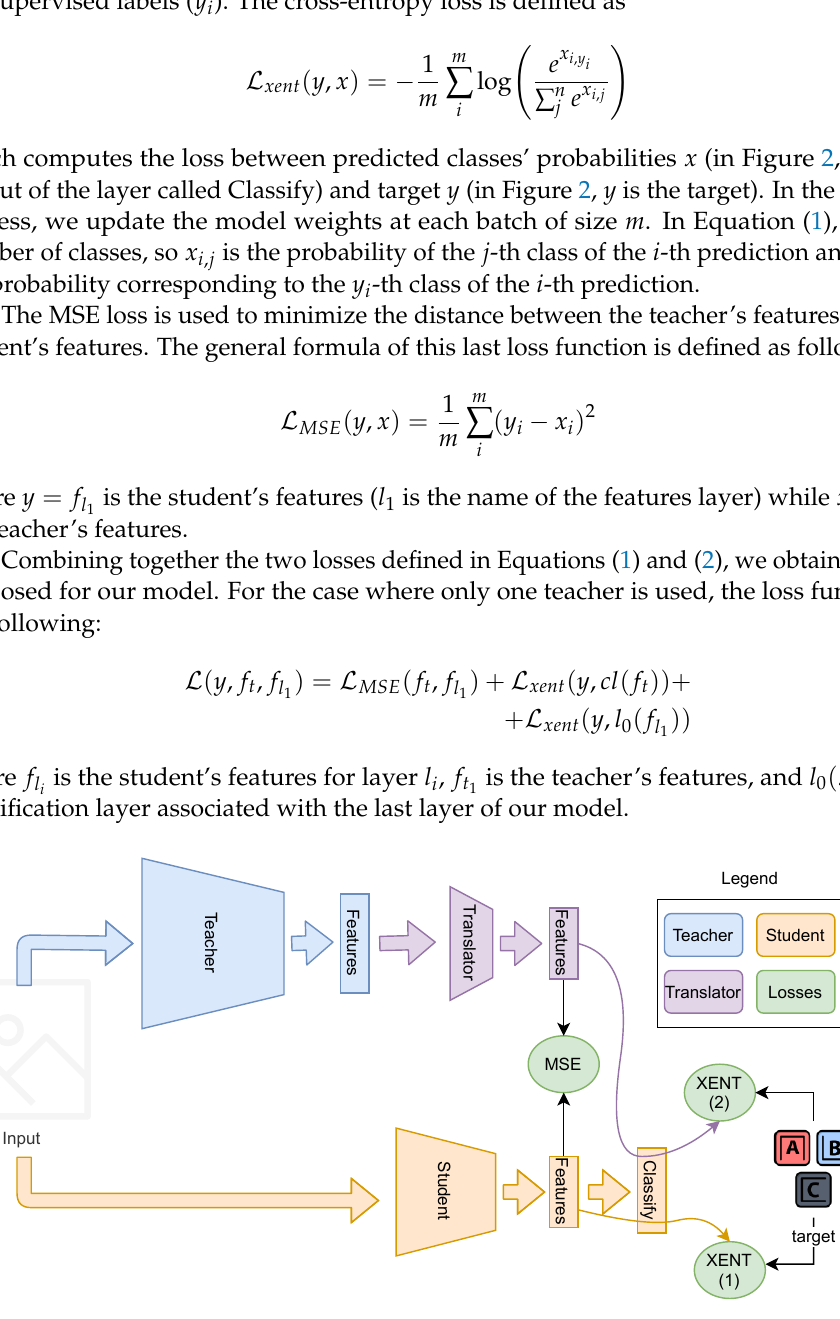
Figure 2. Proposed approach with one teacher. We can distinguish three different networks: the teacher, the translator, and the student. The loss function is composed by the mean squared error (MSE) between the student and translator plus the first cross-entropy (XENT (1)) of the student’s feature and classify layer flow, plus the second cross-entropy (XENT (2)) of the translator’s feature and classify layer